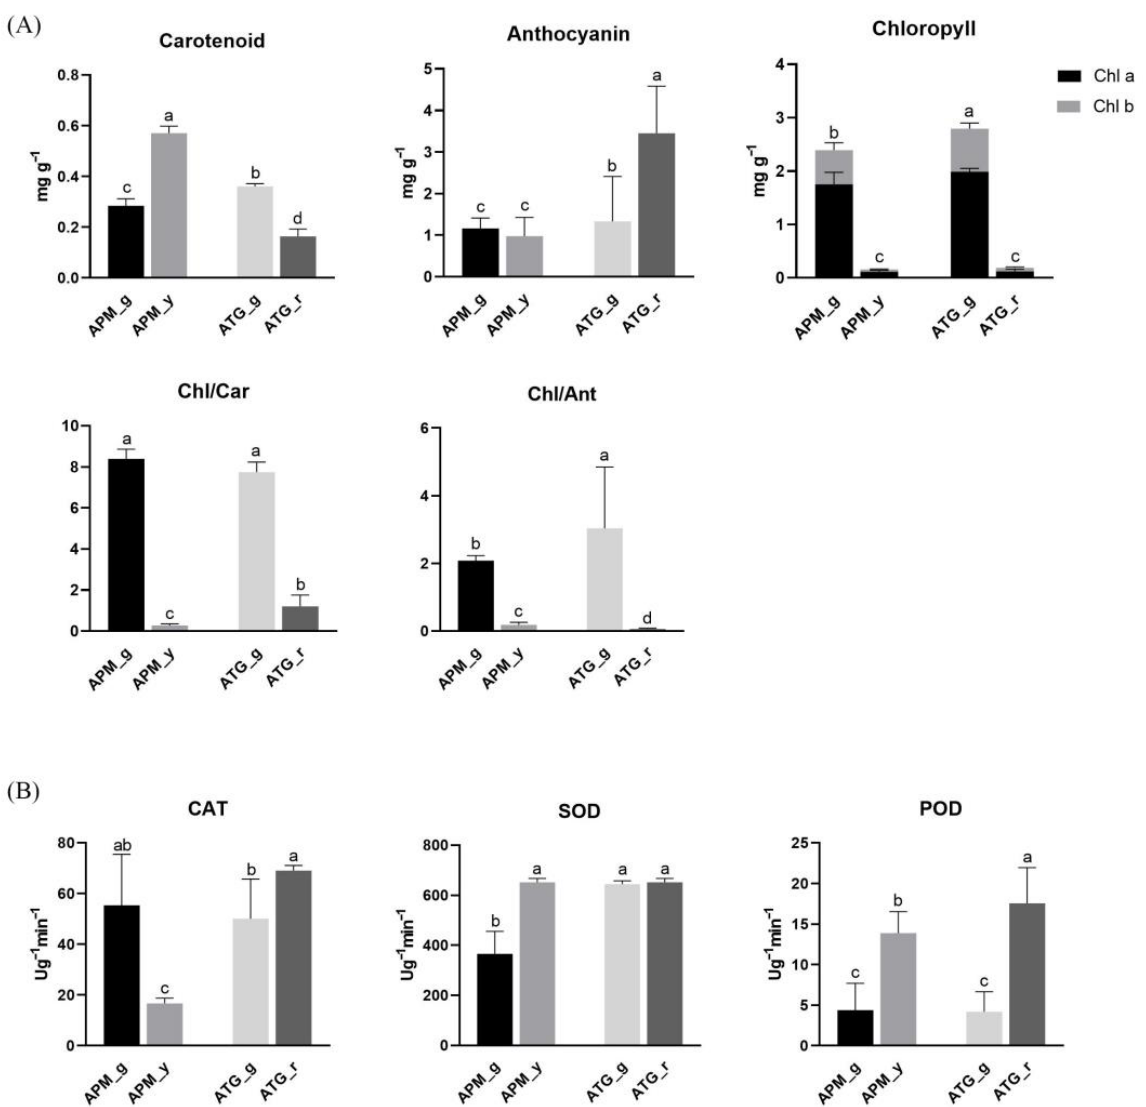
Figure 2. Pigment and antioxidant enzyme of APM and ATG leaves in different seasons: ( A ) pigment content and ( B ) antioxidant enzyme activity. Different letters indicate significant differences in different tissues ( p < 0.05).